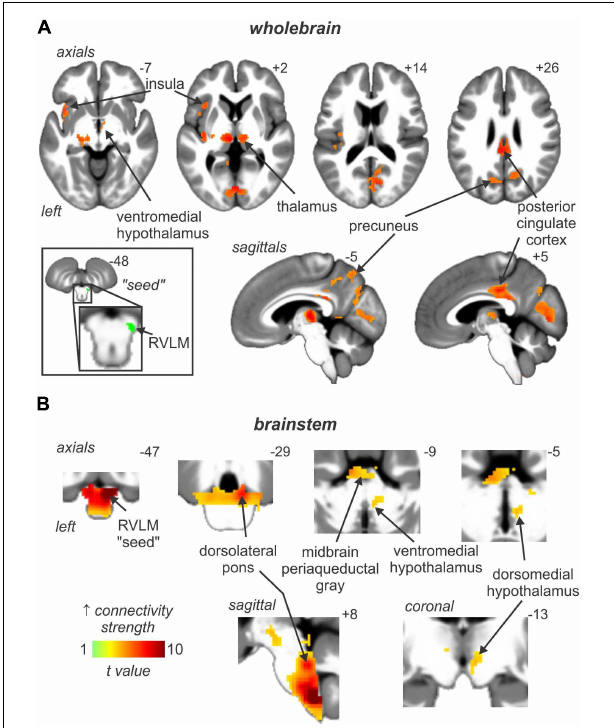
FIGURE 4 | Brain regions in which signal intensity fluctuations at rest are significantly positively coupled to those in the rostral ventrolateral medulla (RVLM) in 29 healthy participants. Results from an analysis focused on rostral brain sites are shown in panel (A) whereas panel (B) focusses on the brainstem only. Significant positive signal couplings with the RVLM are indicated with the hot color scale and overlaid onto and axial, coronal and sagittal slices of a mean T1-weighted anatomical image. Slice locations in Montreal Neurological Space are shown at the top right of each section. Reproduced, with permission, from Macefield and Henderson